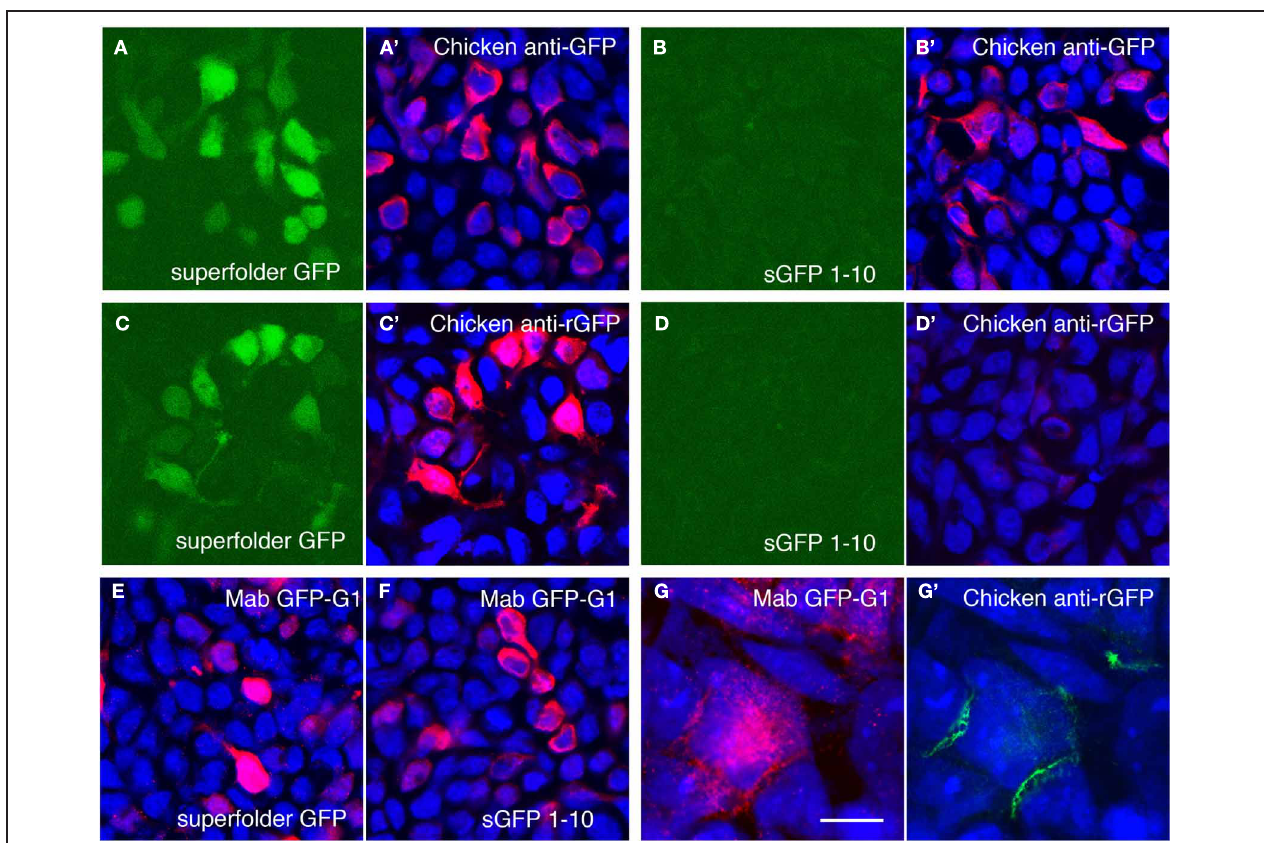
FIGURE 3 | Amplification of GRASP signal using antibodies recognizing reconstituted GFP. (A,B) Superfolder GFP is fluorescent when expressed in 293 cells (A) whereas split GFP1–10 is not (B) . Chicken antibodies to bacterially expressed superfolder GFP recognize both proteins (A’,B’) . Blue channel shows counter-staining with Neurotrace 435. (C,D) Following absorption to sGFP1–10 and tissue, the same antibodies react with fluorescent superfolder GFP (C,C’) , but not sGFP1–10 (D,D’) . (E,F) Mouse